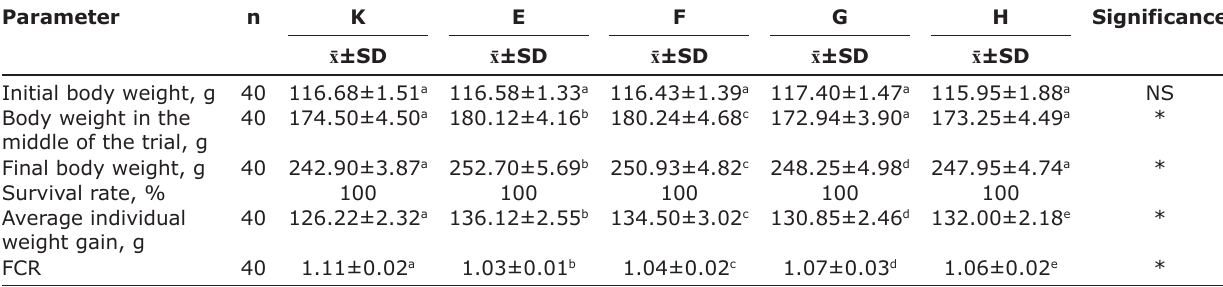
Table-3: Growth performance parameters of rainbow trouts ( Oncorhynchus mykiss W.). Parameter